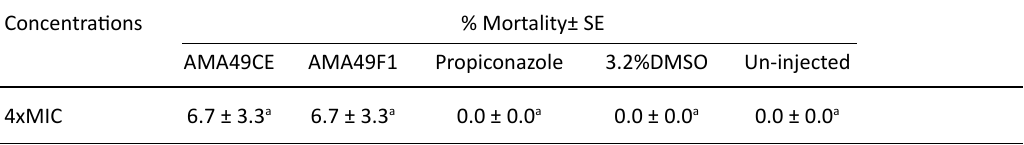
Table 4. Percent mortality of Galleria mellonella treated with extracts from Streptomyces sp. AMA49 Concentrations